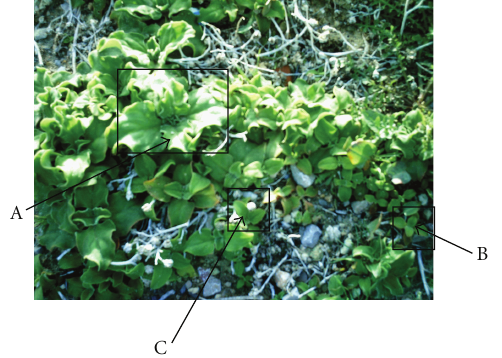
Figure 1: Mesembryanthemum crystallinum at December 2008 with three growth stages. (a) Adult; (b) juvenile; (c) seedlings.